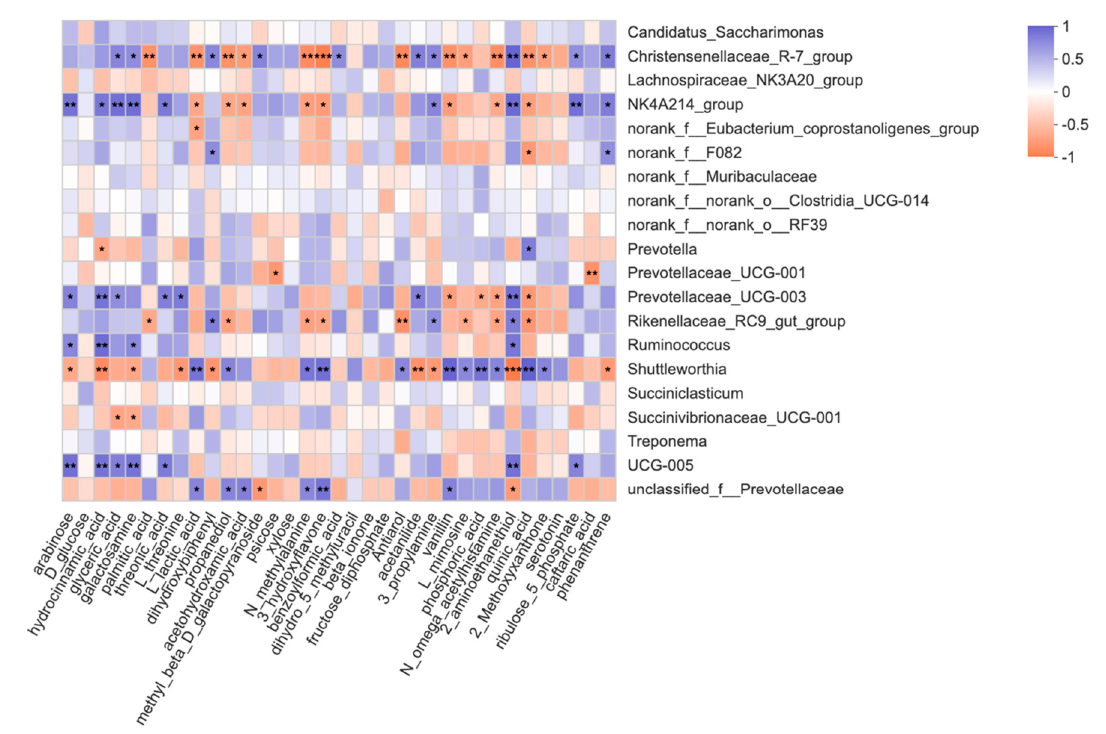
Figure 7. Correlation analyses between the differential metabolites and top 20 ruminal bacterial genera in both groups. The blue squares represent the positive correlations while orange ones represent the negative correlations. * p < 0.05, ** p < 0.01; *** p < 0.001.